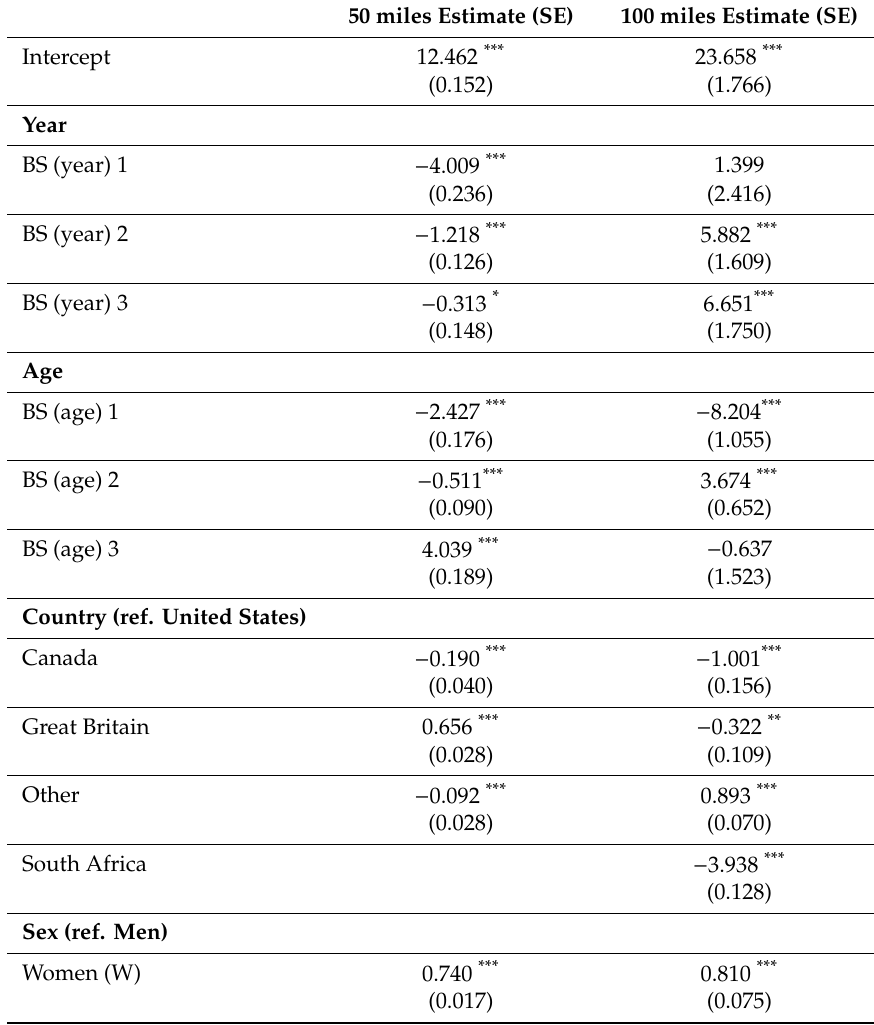
Table 2. Regression analysis (mixed model) of ultra-marathons (50 and 100 miles). Estimates and standard errors (SEs) of fixed e ff ects are reported. P-value ranges are marked with asterisks (see note). Smoothing terms, basis splines, are denoted with BS(x) t, where x = year, age; t =